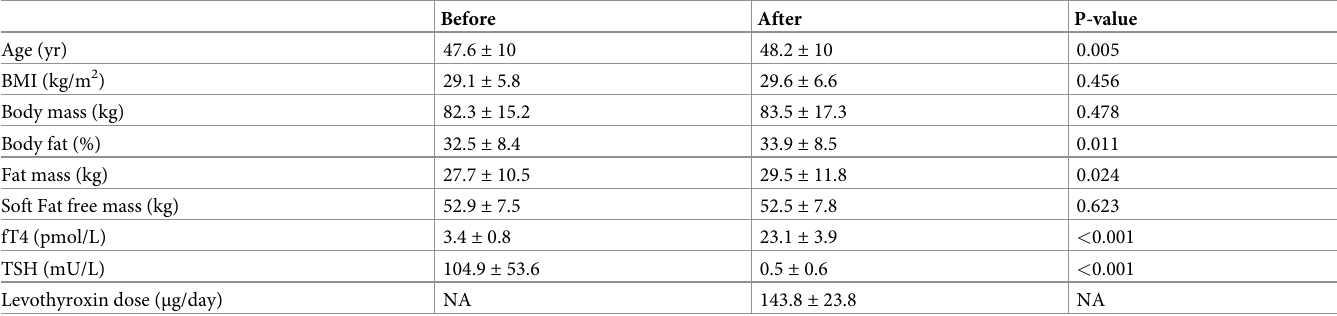
Subject characteristics in ten patients (two male, eight female) with measurements in the hypothyroid and euthyroid phase of thyroid carcinoma treatment. BMI indicates Body Mass Index. Values are expressed as means ± SD.